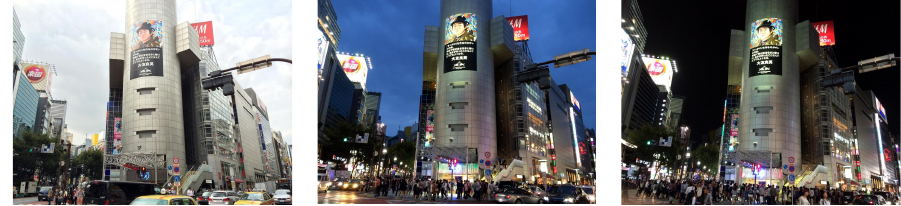
Figure 1. TokyoTimeMachine dataset [19] images from the same place with different illumination conditions: day, sunset, night.